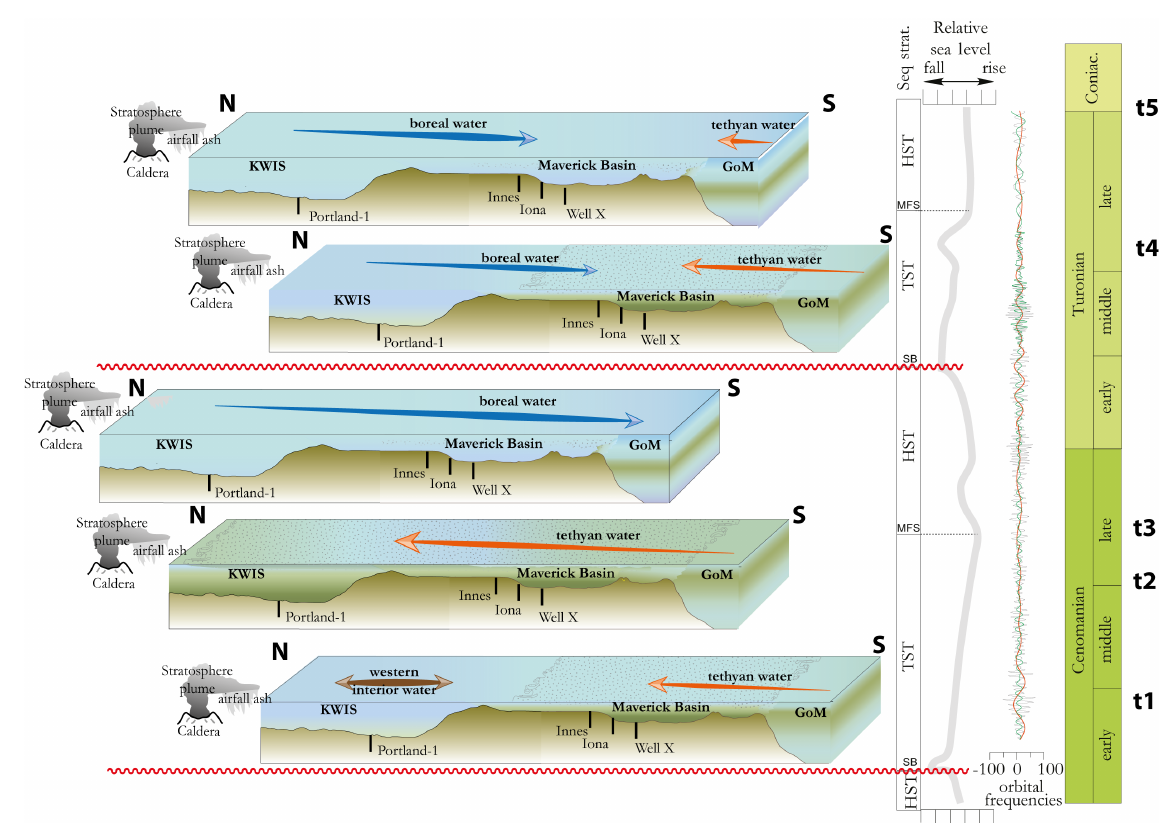
Figure 14. Regional water-mass depositional model of the KWIS. Time slices (t1–t5) showing the northward flow of eutrophic/anoxic Tethyan equatorial Atlantic water into the Western Interior Seaway and southward flow of a boreal water mass. Milankovitch orbital frequen- cies of eccentricity, obliquity and precession from the Iona-1 core (Eldrett et al., 2015a) resulting in shorter-term (<0.1Myr) development of limestone–marlstone couplets (Eldrett et al., 2015b). GoM: Gulf of Mexico. Sea level curve after Minisini et al.